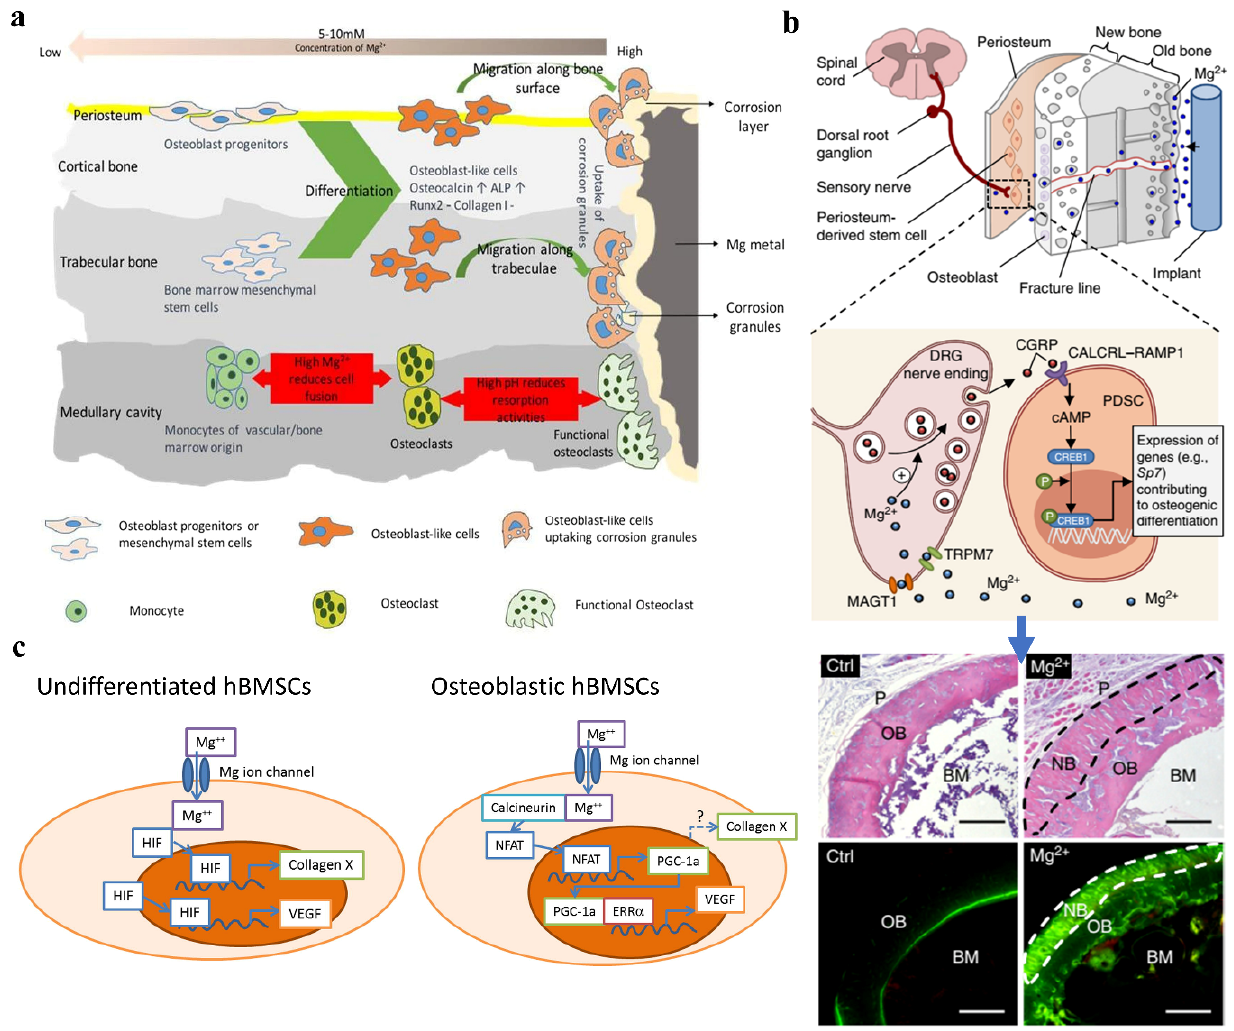
Figure 5. ( a ) Schematic diagram illustrating the cellular response to the Mg and pH gradient after implantation of Mg-based alloy screw. Both bone marrow stem cells and periosteal stem cells differentiate into osteoblast-like cells and migrate to the implantation site to remove the corrosion granules. Reproduced with permission from [102]. Copyright 2018, Springer Nature. ( b ) Robust bone formation at the periosteal region demonstrating the differentiation of periosteum stem cells through the activation of Mg-induced calcitonin gene-related peptide (CGRP), as well as the new bone formation in the mid-shaft of rat femora intramedullary implanted with a Mg or SS (Ctrl) rod for 2 weeks. Reproduced with permission from [103]. Copyright 2016, Springer Nature. ( c ) Schematic of hypothesized intracellular signaling cascades by Mg ion stimulation of hBMSCs. Mg 2+ will directly promote the expression of hypoxia-induced factor (HIF) in BMSCs, leading to enhanced chondrogenesis and osteogenesis. Reproduced with permission from [104]. Copyright 2014,